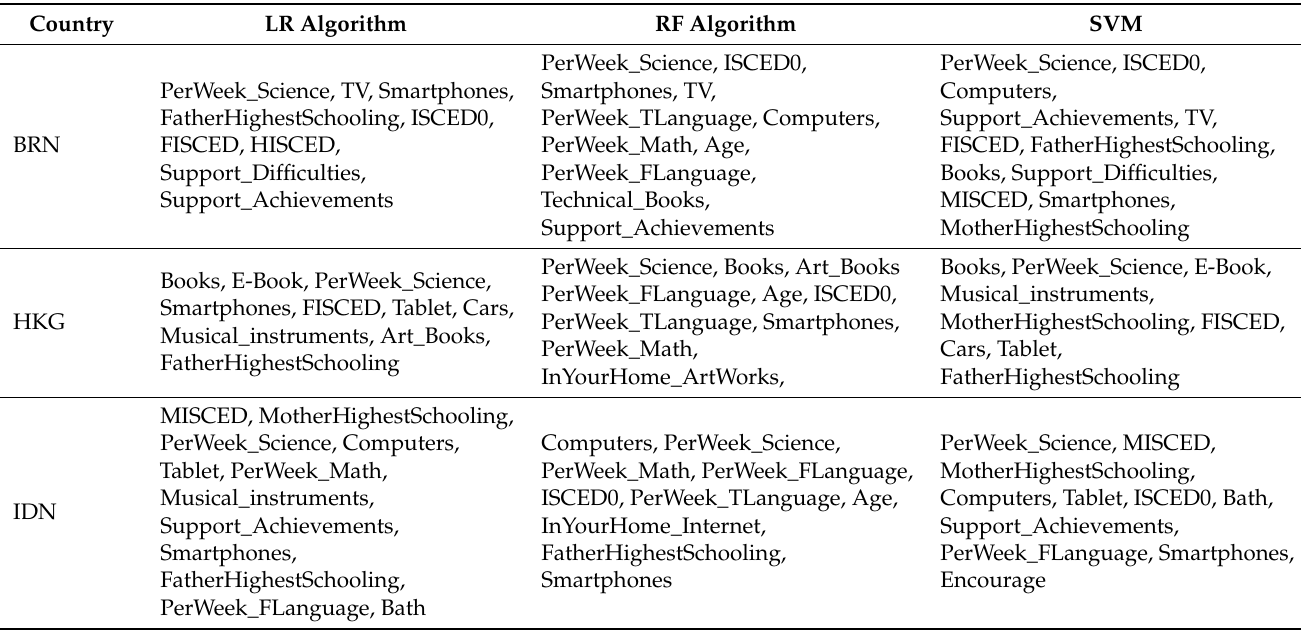
Table 6. High-importance features of countries according to three classification